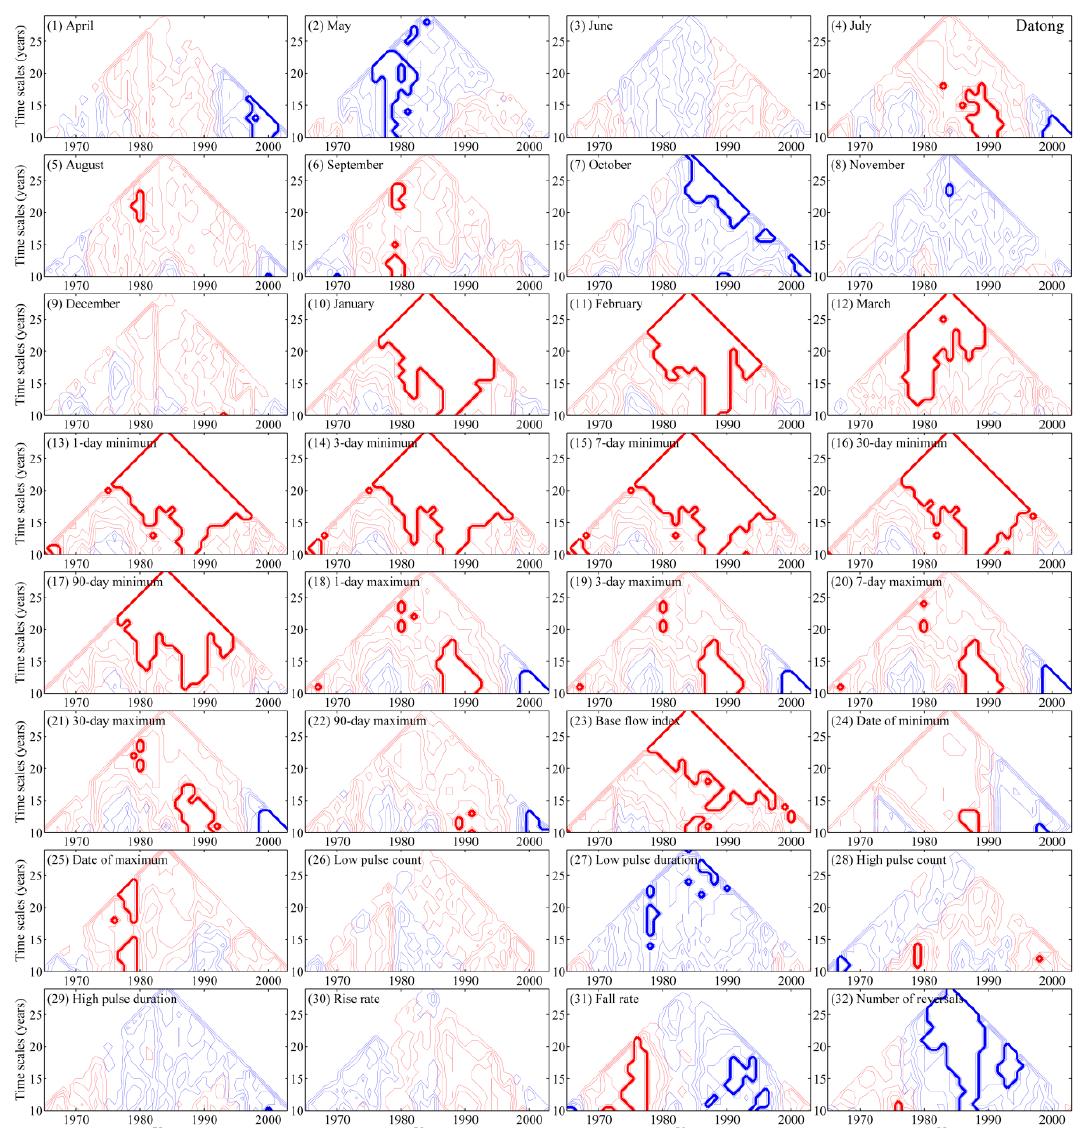
Figure 13. Change points on different time scales of the hydrologic regime at the Datong station.